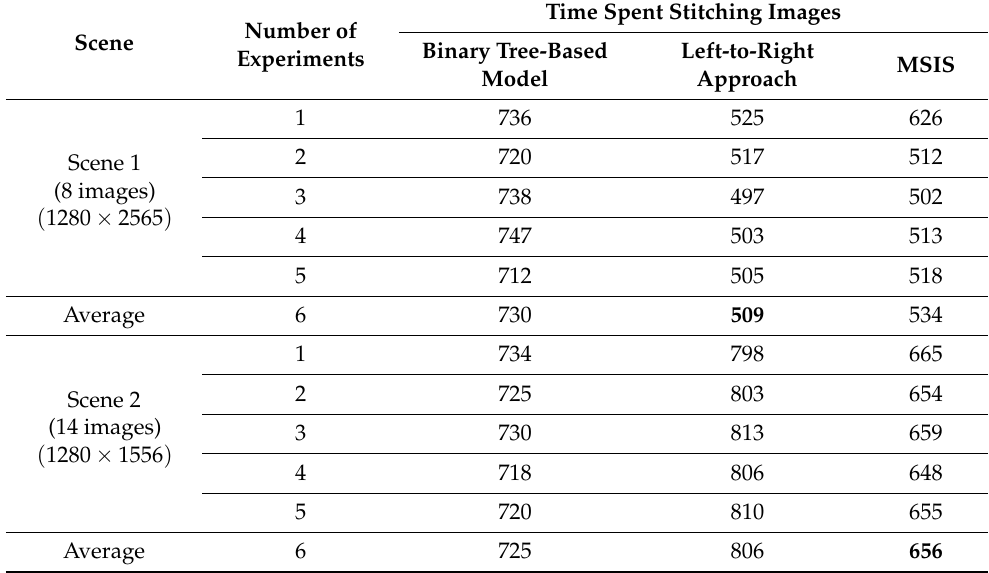
Table 2. Time required for stitching images with each method for the two experimental scenes (unit: